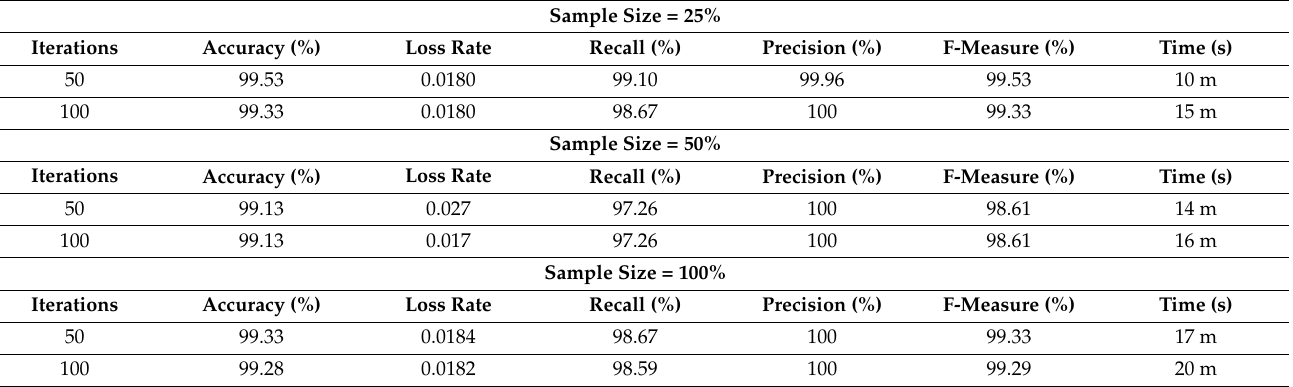
Table 9. Experimental Results of the third scenario.